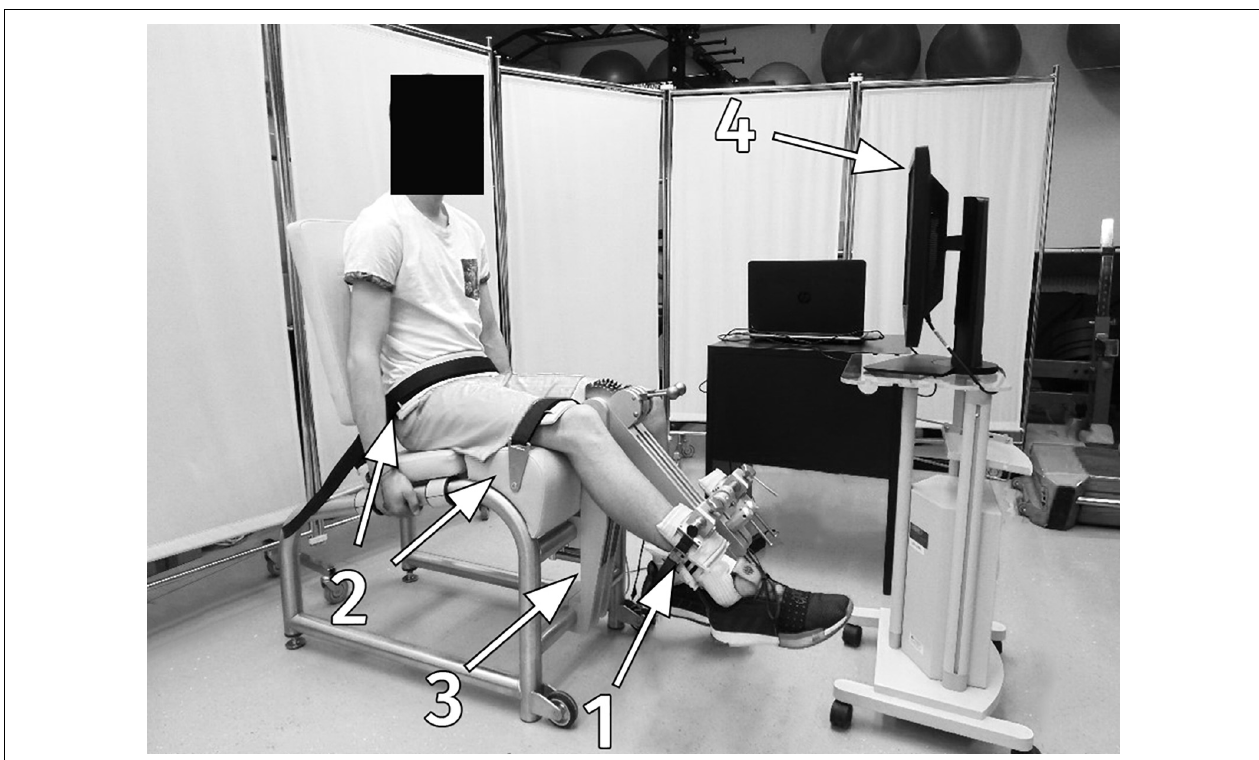
FIGURE 1 | Measurement set-up; the subject in the isometric knee dynamometer: 1, a minimally padded shank support; 2, rigid straps for the knee and pelvis fixation; 3, a strain gage force sensor; 4, a monitor with visual feedback.